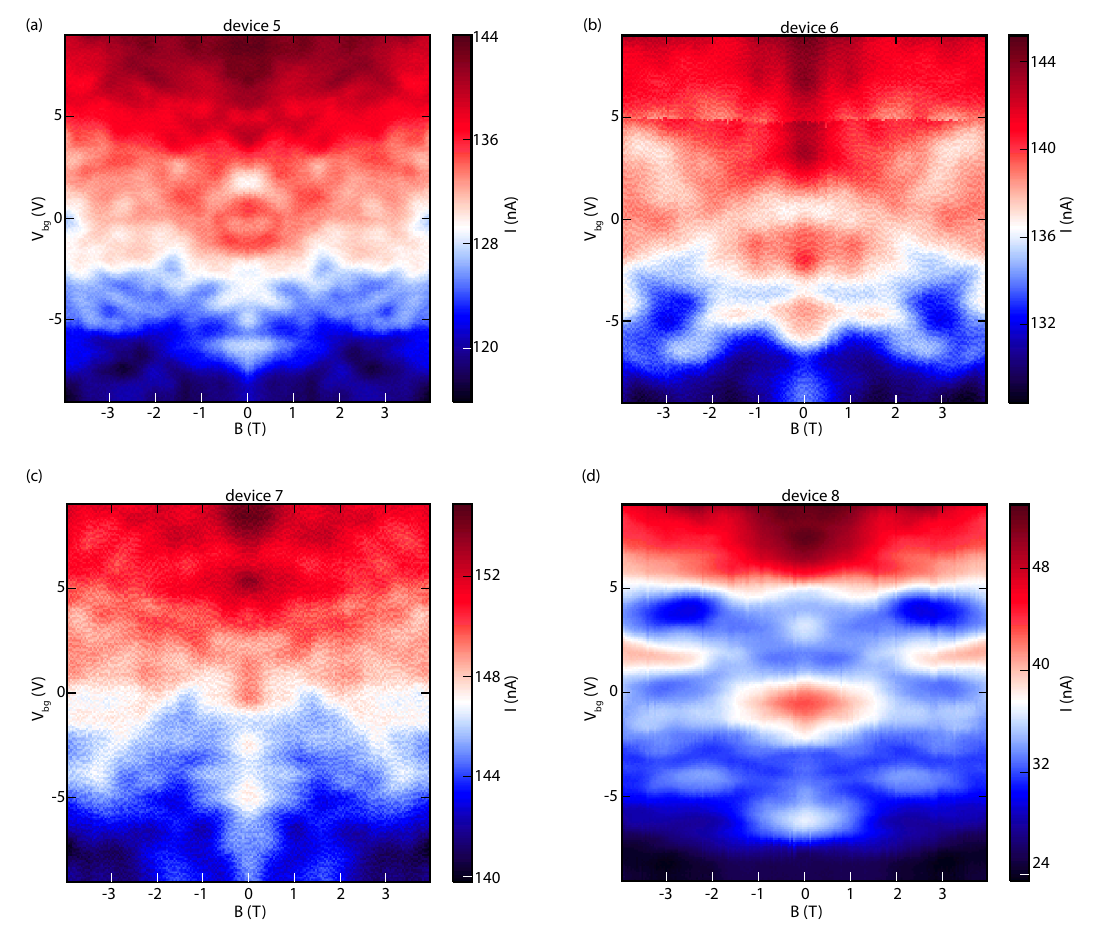
Figure S10: Magnetic field evolution of conductance in devices without a top gate shown in Fig. S9. ( a is from device 5, b is from device 6, c is from device 7, d is from = 1mV, magnetic field direction varies for every device. It is applied device 8. V bias horizontally with respect to images in Fig. S1, resulting in (a) 14, (b) 63, (c) 86, (d) = -5V is estimated to be 11 58 degree angle. G-factor in d (device8) for state at V bg after converting backgate voltage to bias using lever arm from data in Fig. S10 d